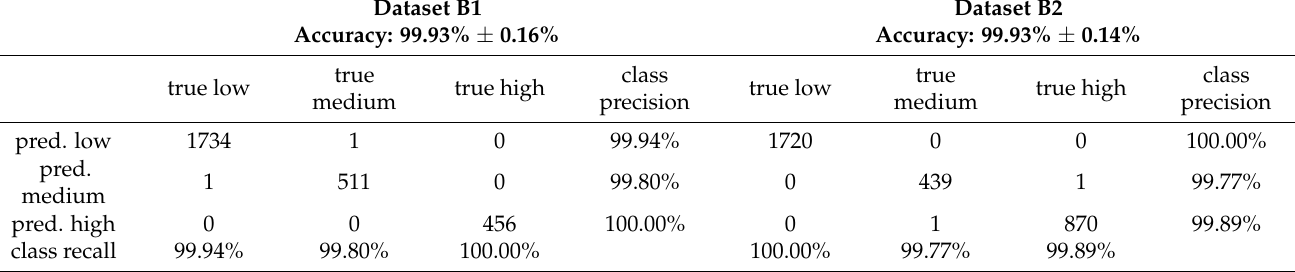
Table 3. Confusion matrix with the classification generated with algorithm RF and datasets B1 and B2. A contrast between the classifications obtained with the datasets above is shown, along with accuracy, recall, and class-precision values for both